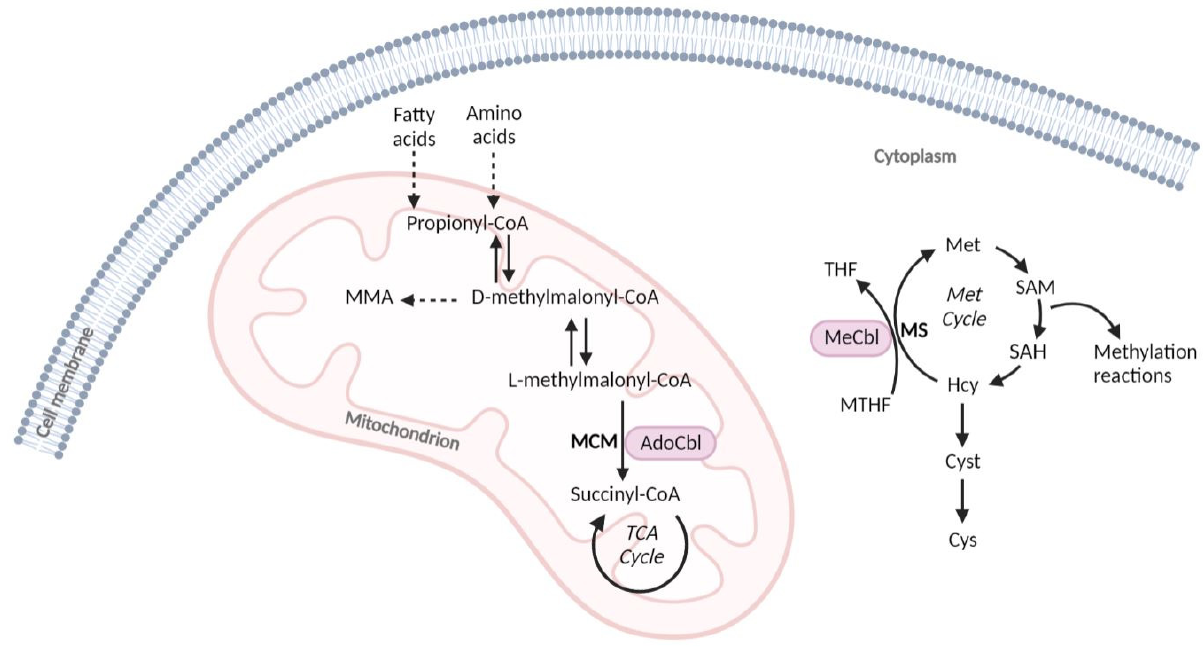
Figure 1. Simplified scheme of the two metabolic pathways that use cobalamin cofactors. AdoCbl, adenosylcobalamin; Cys, cystine; Cyst, cystathionine; Hcy, homocysteine; MeCbl, methylcobalamin; Met cycle, methionine cycle; MCM, methylmalonyl-CoA mutase; MMA, methylmalonic acid; MS, methionine synthase; MTHF, N5-methyltetrahydrofolate; SAH, S-adenosylhomocysteine; SAM, S-adenosylmethionine; TCA cycle, tricarboxylic acid cycle; THF, tetrahydrofolate.